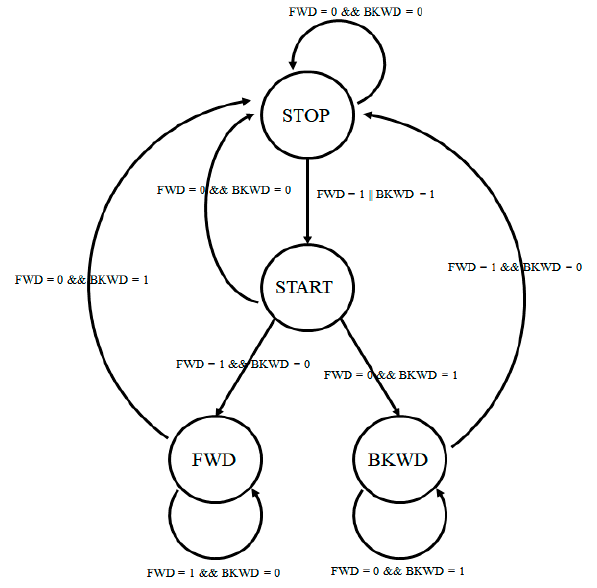
Figure 13. DC–DC converter control signal state diagram.